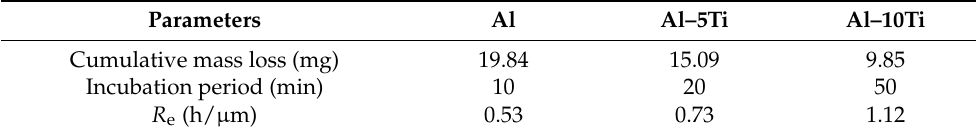
Figure 1. Schematic diagram of device for preparing high-purity Al–Ti alloys by direct reaction of Ti powder and Al melt. 1—Bottom liquid outlet, 2—heating pipe, 3—temperature controller, 4—melt, 5—upper liquid outlet, 6—observation hole, 7—thermocouple, 8—cooling water jacket, 9—transducer, 10—feed inlet, 11—furnace cover, 12—furnace body, 13—horn, 14—ultrasonic transmitter, 15—Ti powder, 16—vertical partition plate, 17—ceramic crucible, A—composition homogenization zone, B—alloying reaction zone. Table 1. Weight loss, incubation period, and cavitation erosion resistance of Al, Al–5Ti, and Al–10Ti alloys in 3.5 wt.% NaCl